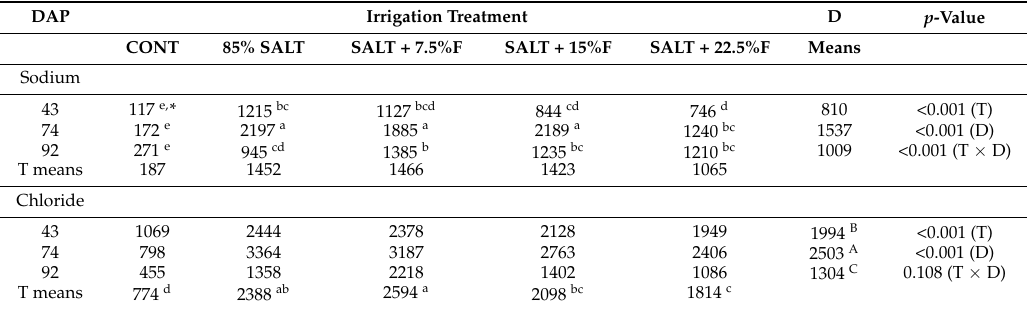
Table 2. The effects of irrigation treatment (T) and sample date (D), specified as DAP, on sodium and chloride concentration in leaves (mmol/kg dry weight).